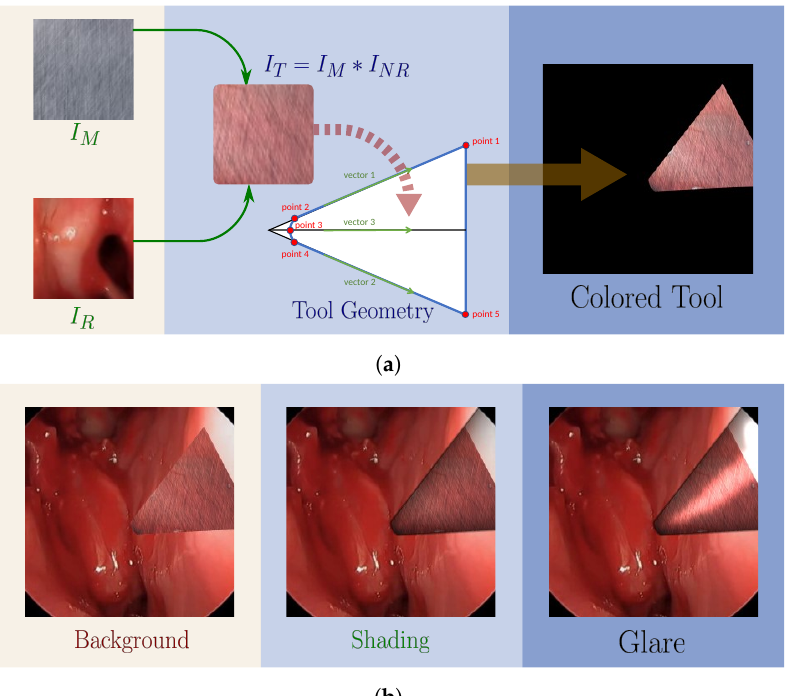
Figure 1. The baseline tool image generation procedure ( a ) tool color ( I M ∗ I NR ) and tool geometry fused to create colored tool patch. ( b ) Post-processing steps by overlaying tool patch on background, shading, and glare